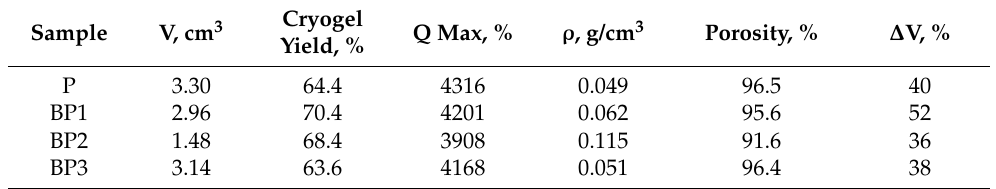
Table 1. Properties of cryogel samples from biomodified kraft pulp with different conversion rates.